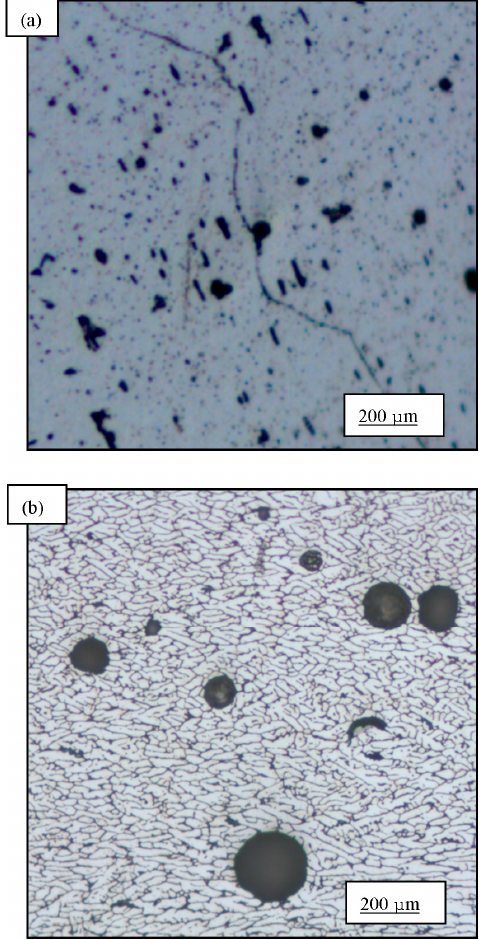
Figure 6. Optical micrographs of AA6061 showing the following: ( a ) Distribution of intermetallic particles in the base metal adjacent to the weld bead; and ( b ) microstructure of the weld pool of the heat ‐ treated alloy.